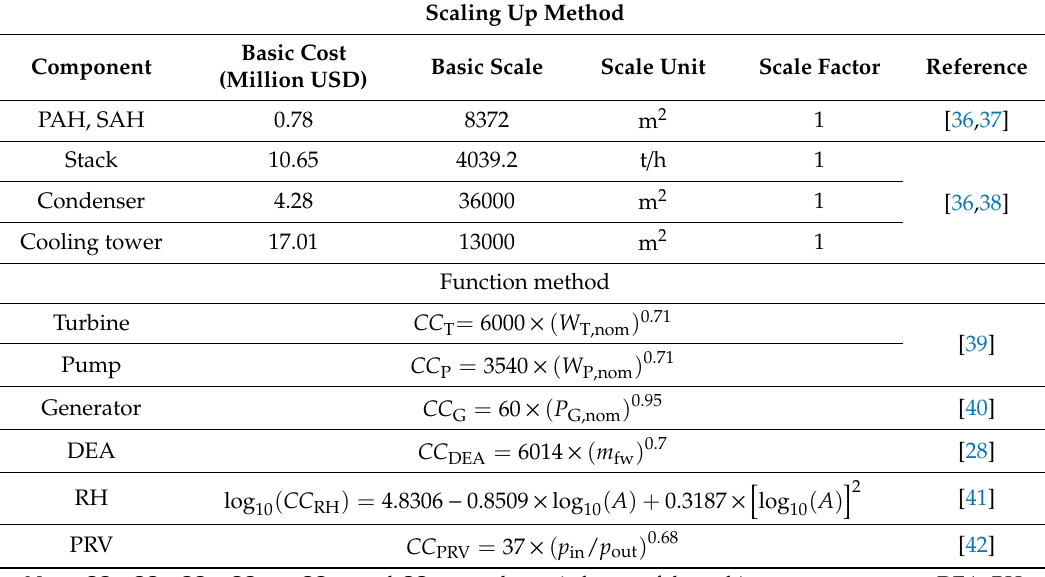
Table 12. Capital cost estimation methods for the changed